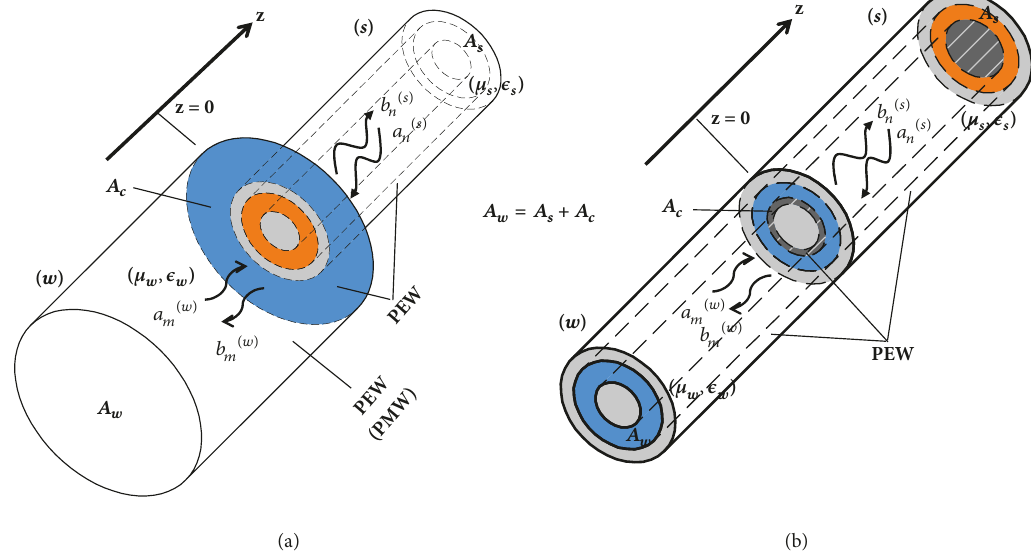
Figure 5: Basic waveguide step between circular and coaxial waveguides for the models in Figure